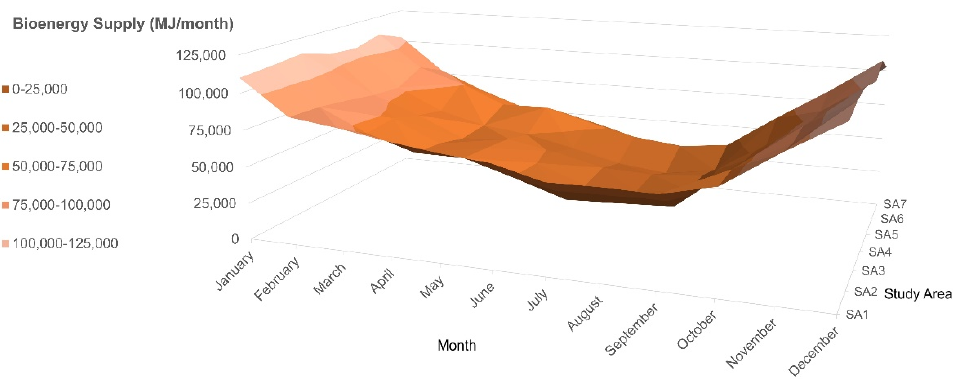
Figure 8. Solar supply in the hybrid-modular system per month by sector. December has the lowest level of solar energy supply, with an average of 30 GJ/month per sector, while August shows the highest solar supply, with a total of 85 GJ/month. Bioenergy supply in the proposed modular system provides about 70% of the total energy supply in any considered area. Bioenergy and solar energy supply are com- bined with the hybrid-modular system to meet the total heating load. In connection with Phases II and III, the “f-factors” per month were examined from the point of view of energy management. Figure 9 summarises the outcome of “f-factors” for the total monthly heating load with bioenergy supply being the main contribution (Table 2).